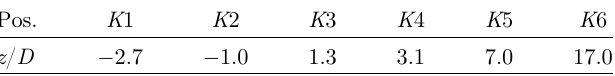
Table 2. Axial positions of the evaluation points (positions of pressure transducer) relative to the pipe diameter D with respect to the leading edge of the ori fi ce.